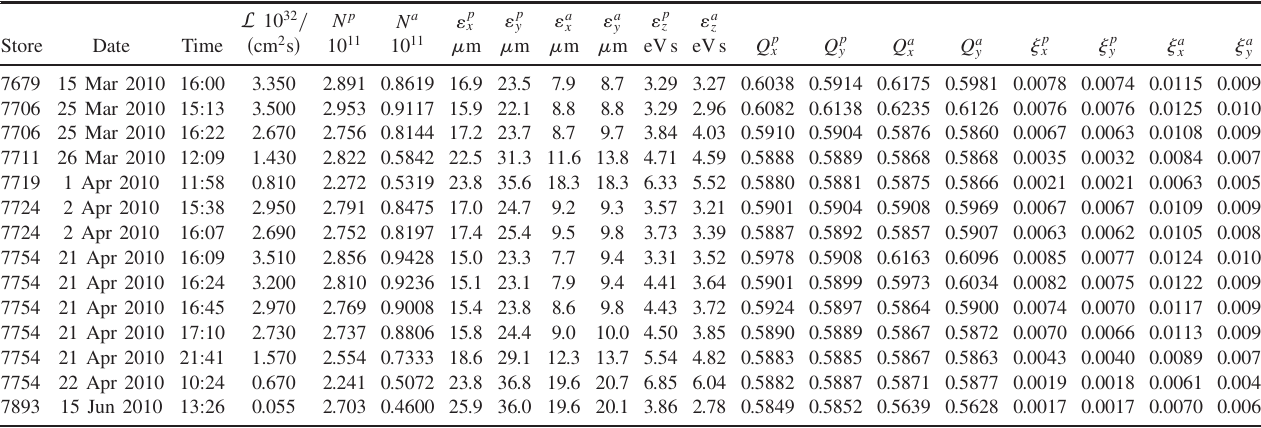
TABLE I. Summary of experimental conditions: instantaneous luminosity, L ; average number of protons and antiprotons per bunch, N p and N a ; average transverse emittances from the synchrotron-light monitor (95%, normalized), " p x , " p y , " a longitudinal emittances, " p z and " a z (1 standard deviation); average incoherent tunes from the 1.7-GHz Schottky detector, Q p x , Q p y , Q a x , and Q a y ; calculated linear beam-beam parameters per interaction point, (cid:4) p x , (cid:4) p y , (cid:4) a x , and (cid:4) a y .